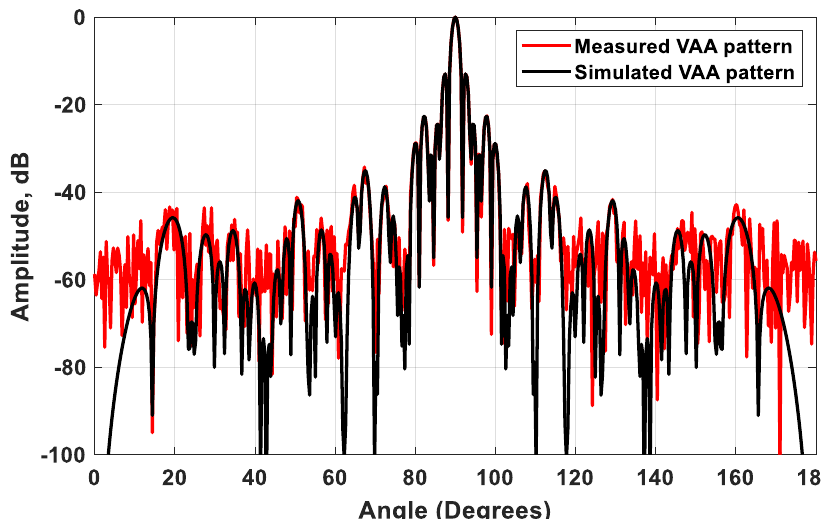
Figure 18. A comparison between the measured and simulated VAA patterns.